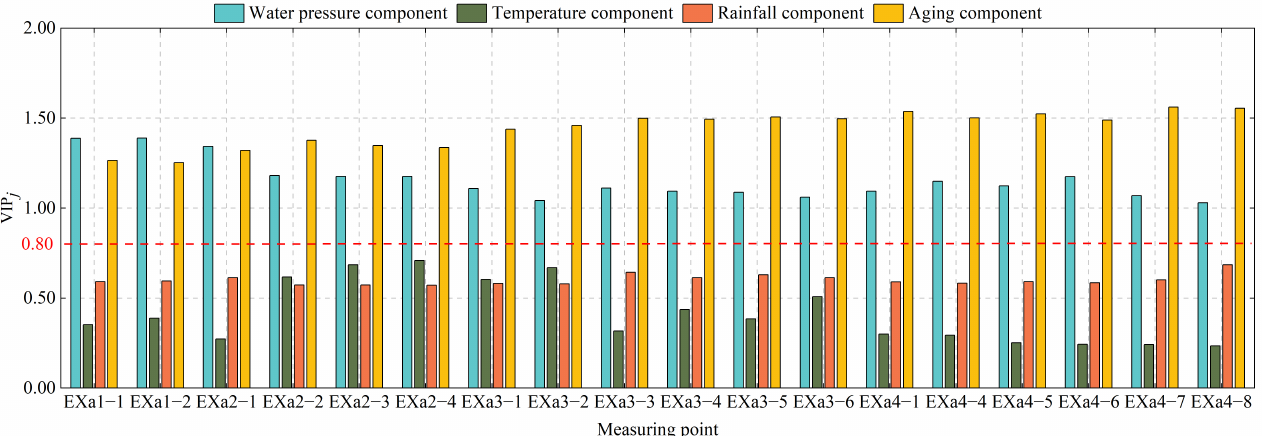
Figure 8. Results of the variable importance for projection of horizontal deformation.